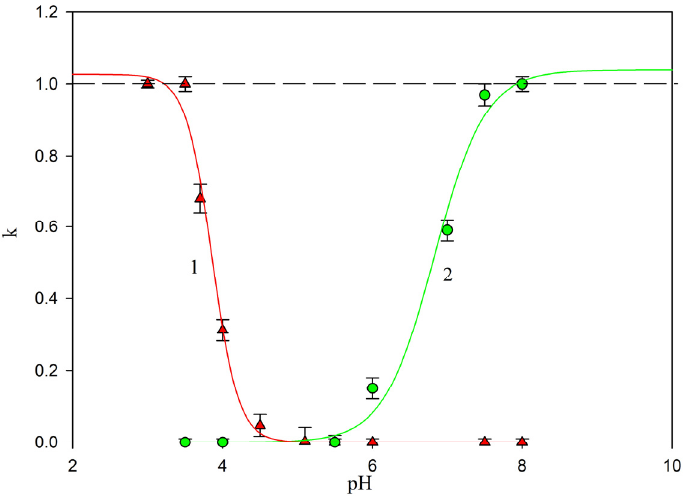
Figure 8. Normalized rate of SAL immunolatex particle deposition on bare mica ( ▲ ) and PAH- modified mica ( ● ) as a function of pH, 1 mM NaCl. Solid lines 1 and 2 represent a fit of experimental data for bare and PAH-covered mica, respectively.